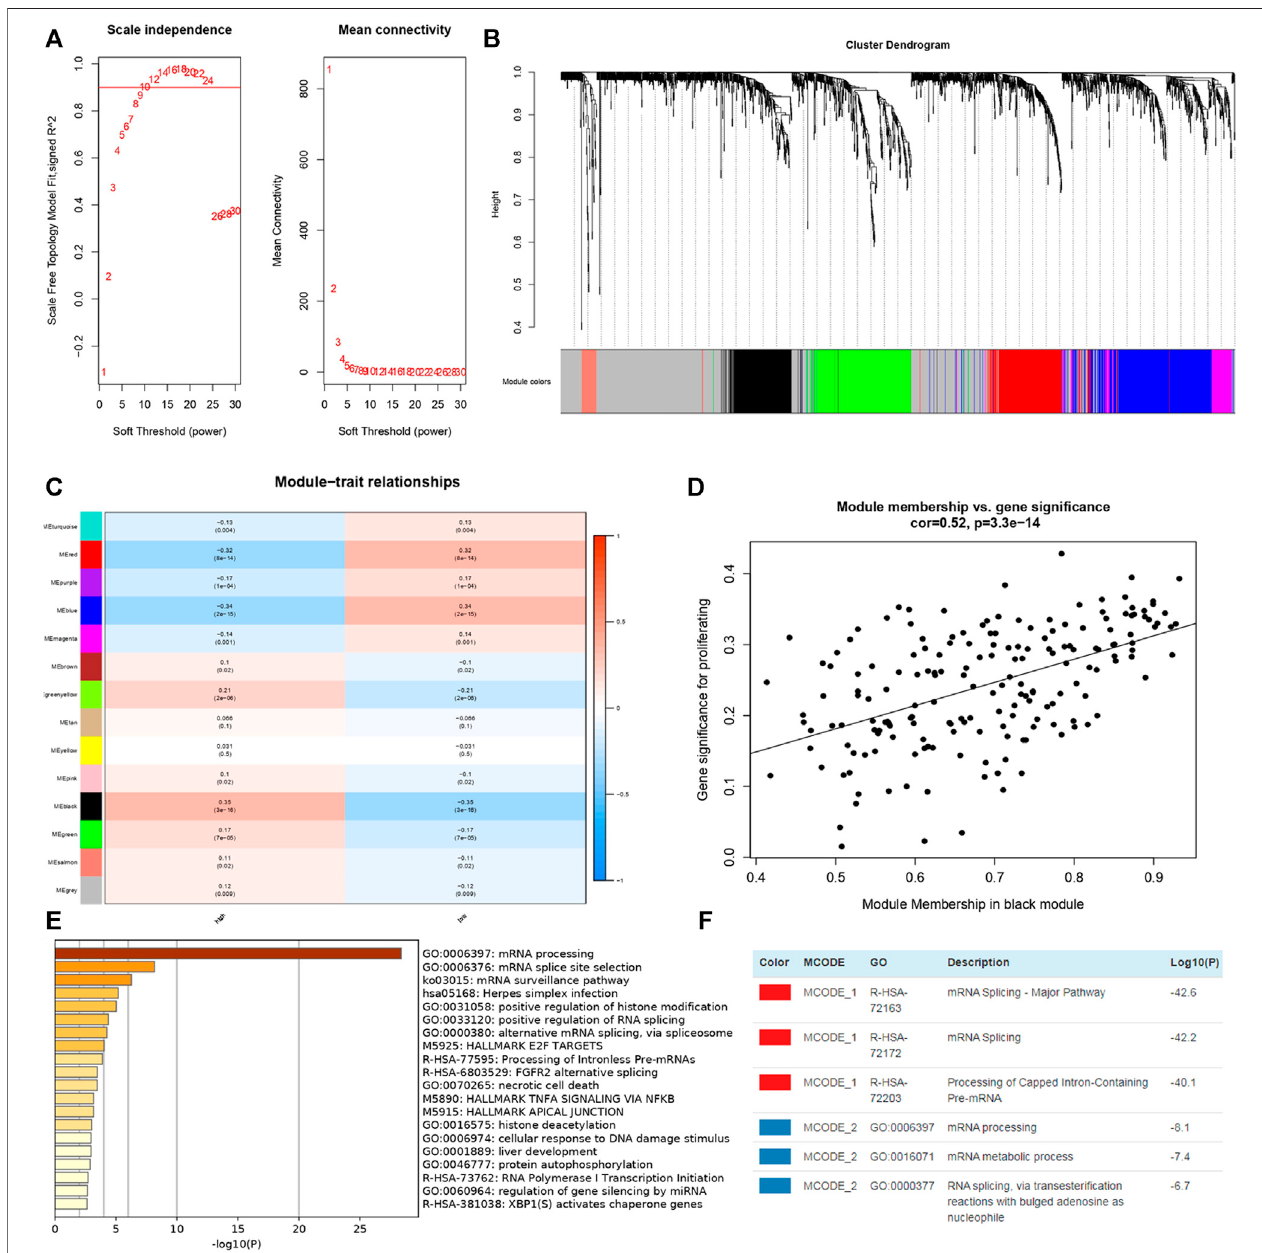
FIGURE 12 | WGCNA in TCGA-KIRC dataset and enrichment analysis of genes in black module from Metascape. (A) Soft thresholding fi ltering. (B) Module screening, 14 modules have been identi fi ed. (C) The relationship between 14 module and different risk groups, the red cells indicated the module was positively related withhigh/low riskgroup while blue cellsrepresentednegativerelationship. (D) Correlationplotbetweengenesinblackmoduleand high riskscore. (E) Top 20pathways enriched in black module. (F) MCODEs of black module.